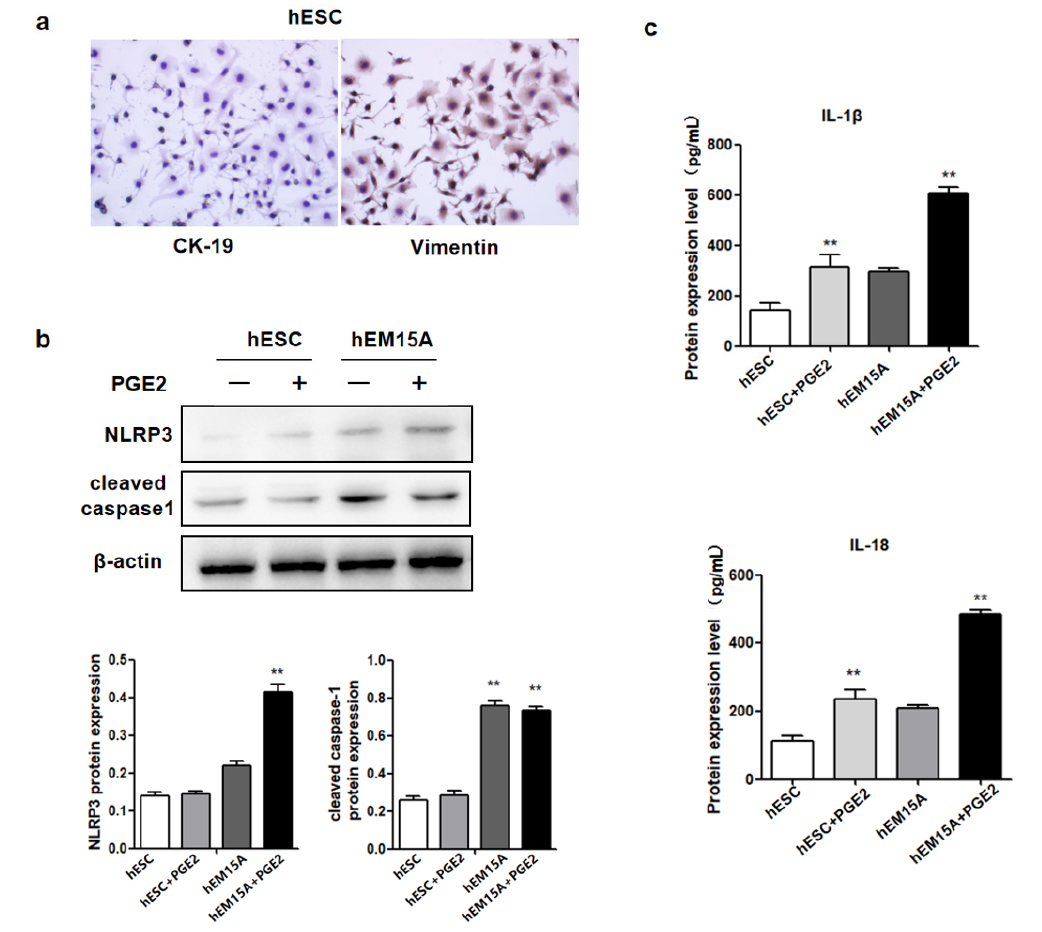
Figure 2. PGE2 induced hEM15A pyroptosis. ( a ) After added 75 ng/mL PGE2 for 24 h in hEM15A and hESC, the protein expression of NLRP3, cleaved caspase-1, IL-1 β and IL-18 were detected by Western blot analysis. ( b ) The level of IL-1 β and IL-18 in cell culture medium were detected by ELISA in hEM15A and hESC. The data are expressed as means ± SEM. ** p < 0.05 by one-way ANOVA. ( c ) ELISA was used to detect the expression of IL-1 β and IL-18 in hESC and hEM15A without and after PGE2 treatment.